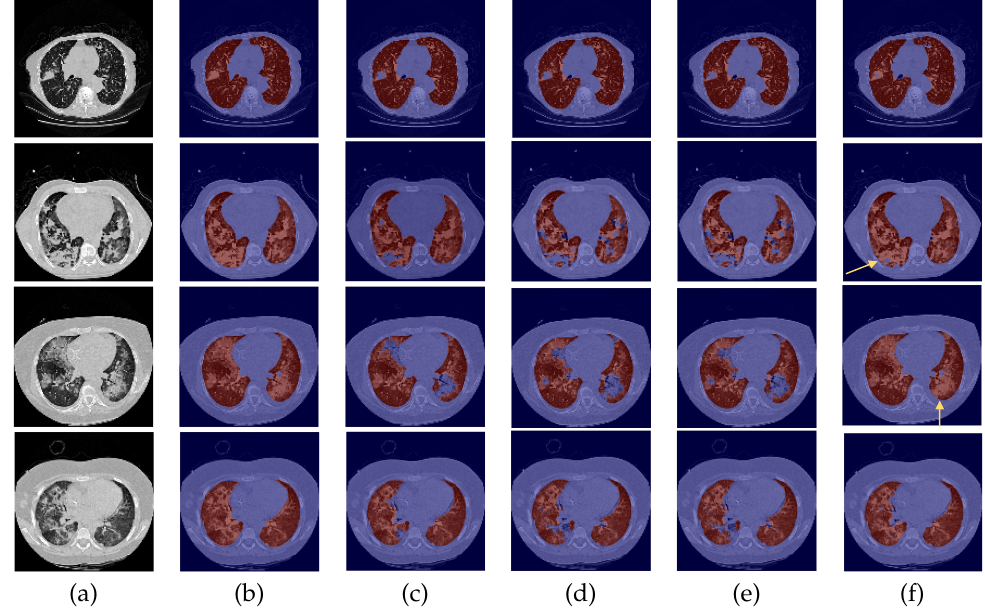
Figure 7. Examples of HUG-ILD scans. From left to right: ( a ) CT original image; ( b ) ground-truth (G-T); ( c ) baseline prediction; ( d ) #2 with DC and without DA predicted mask; ( e ) #3 with DA and without DC predicted mask; ( f ) and #4 with DA and DC predicted